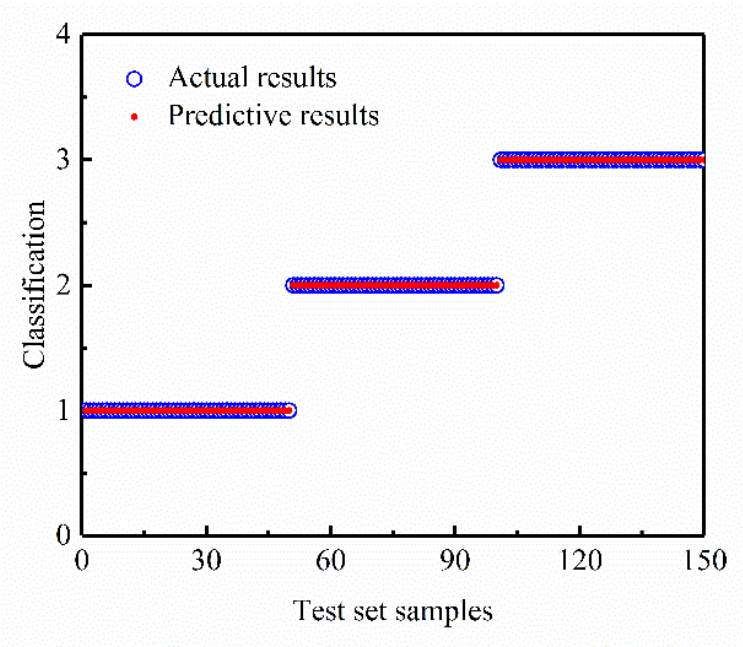
Figure 2. Comparison between predictive results and actual results of SVM model.